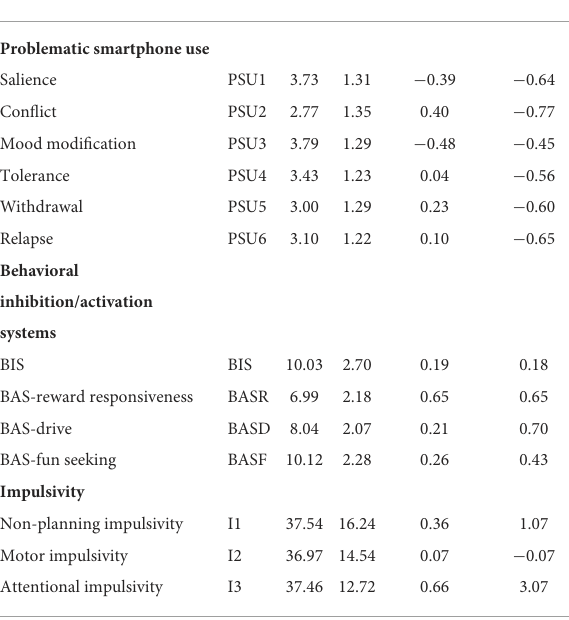
TABLE 1 Abbreviations, mean scores, standard deviations, skewness, and kurtosis for the study